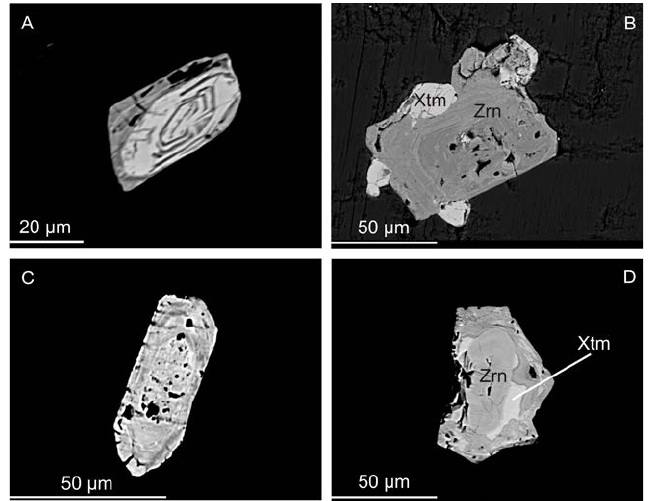
Figure 7. High-contrast BSE images of zircon (Zrn) and xenotime (Xtm) from granites of the Krudum granite body. ( A ) Oscillatory zoning of zircon from the medium-F biotite granite, ( B ) Intergrowth of xenotime with zircon from the high - F, high -P 2 O 5 Li- mica granite, ( C ) Oscillatory zoning of altered zircon in the high - F, high -P 2 O 5 Li mica granite, ( D ) Inherited zircon grains overgrown by younger zircon and xenotime from the high - F, high -P 2 O 5 Li- mica granite.